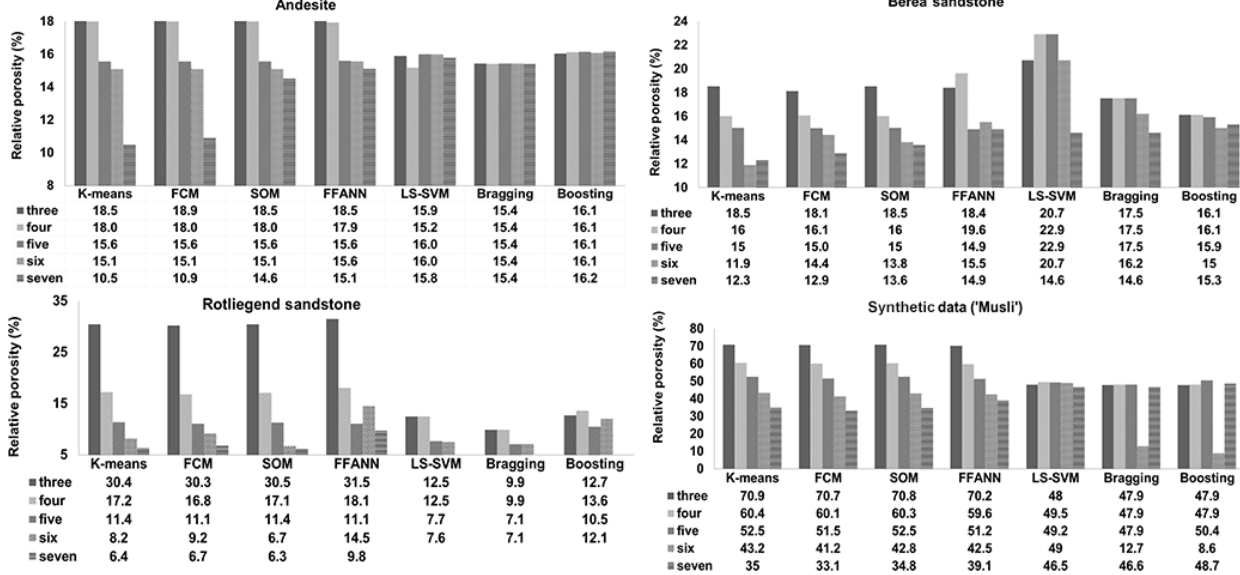
Figure 2. Relative porosity values obtained using unsupervised, supervised and ensemble classifier techniques for respective